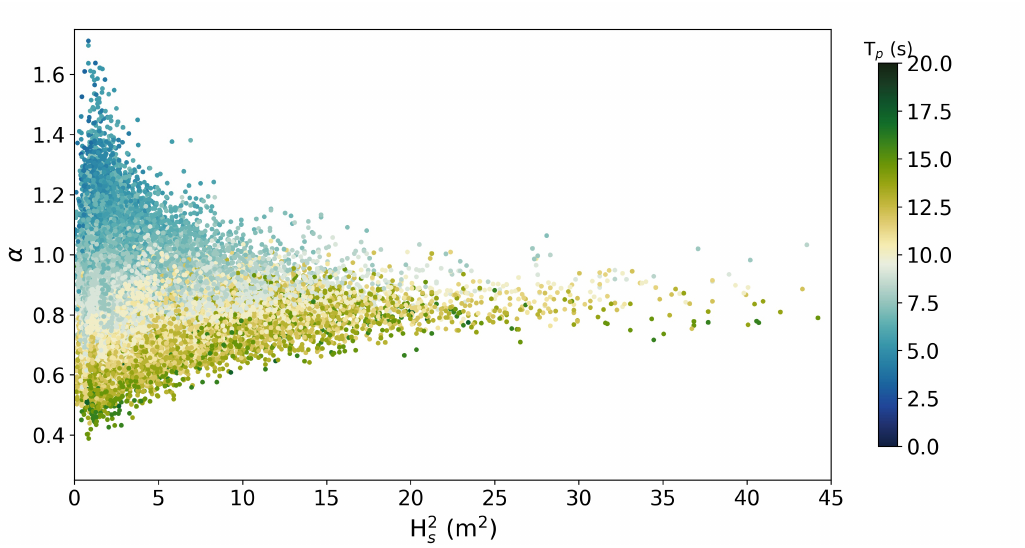
Figure 2. Evolution of the calibration coefficient α between T e and T p ( T e = α T p ) with respect to the significant wave height H s squared and the peak period T p at NDBC wave buoy 41,046 off the Bahamas (North-West Atlantic) adapted from